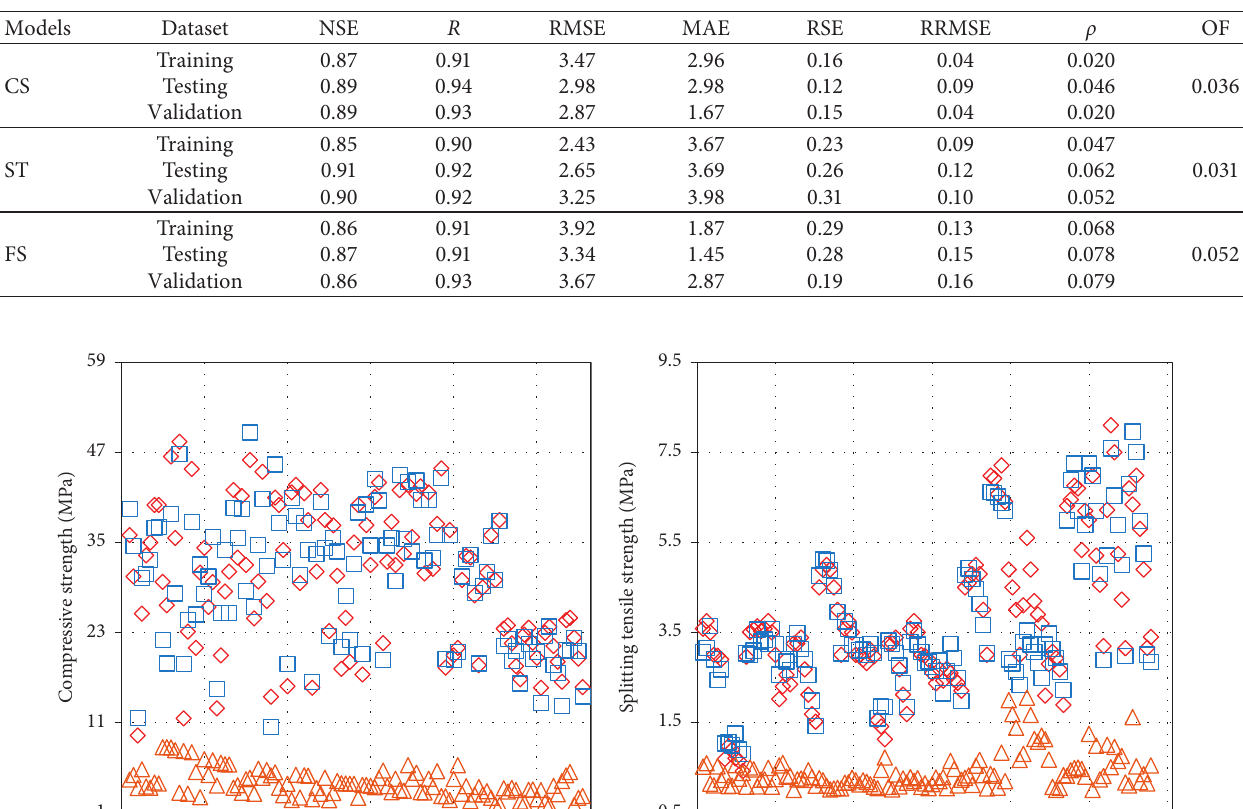
Table 6: Statistics for the training, testing, and validation dataset of the models.